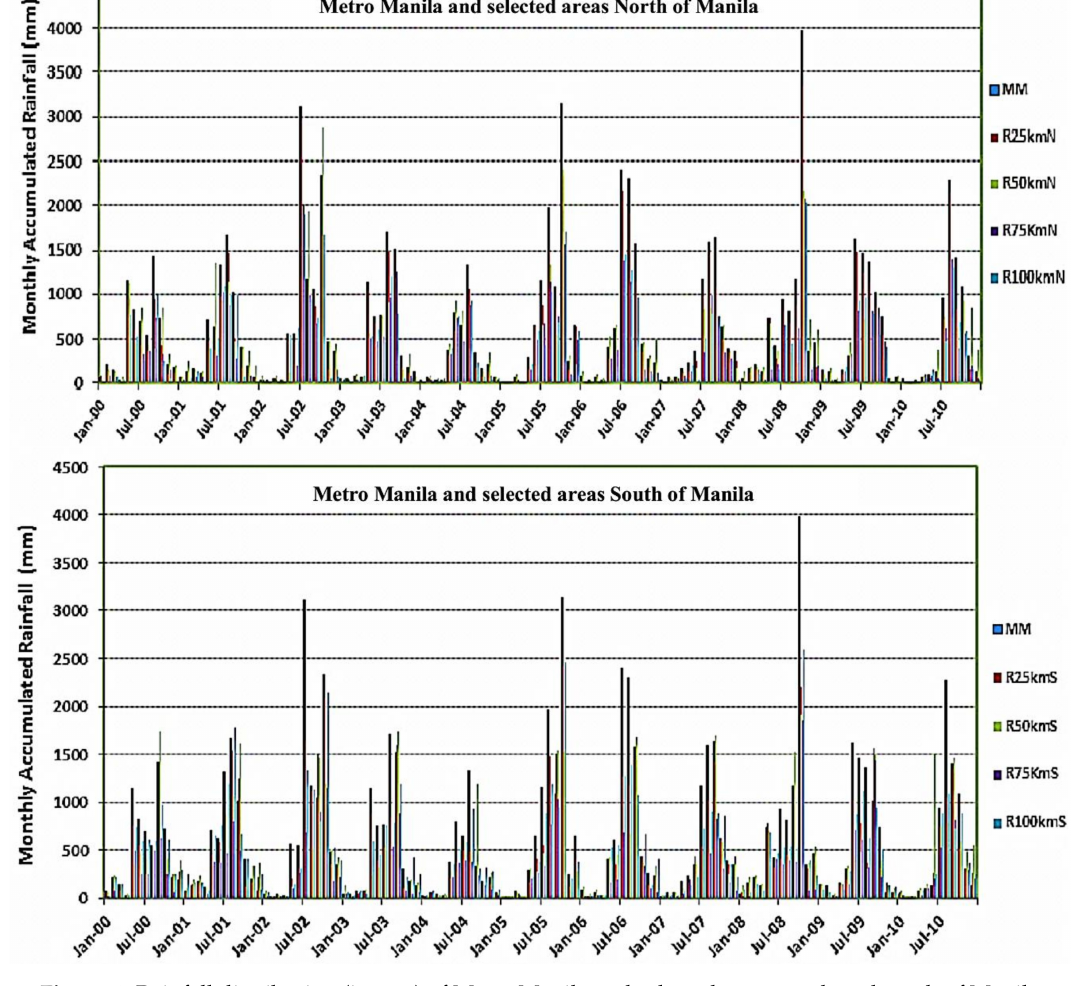
Figure 4. Rainfall distribution (in mm) of Metro Manila and selected areas north and south of Manila for